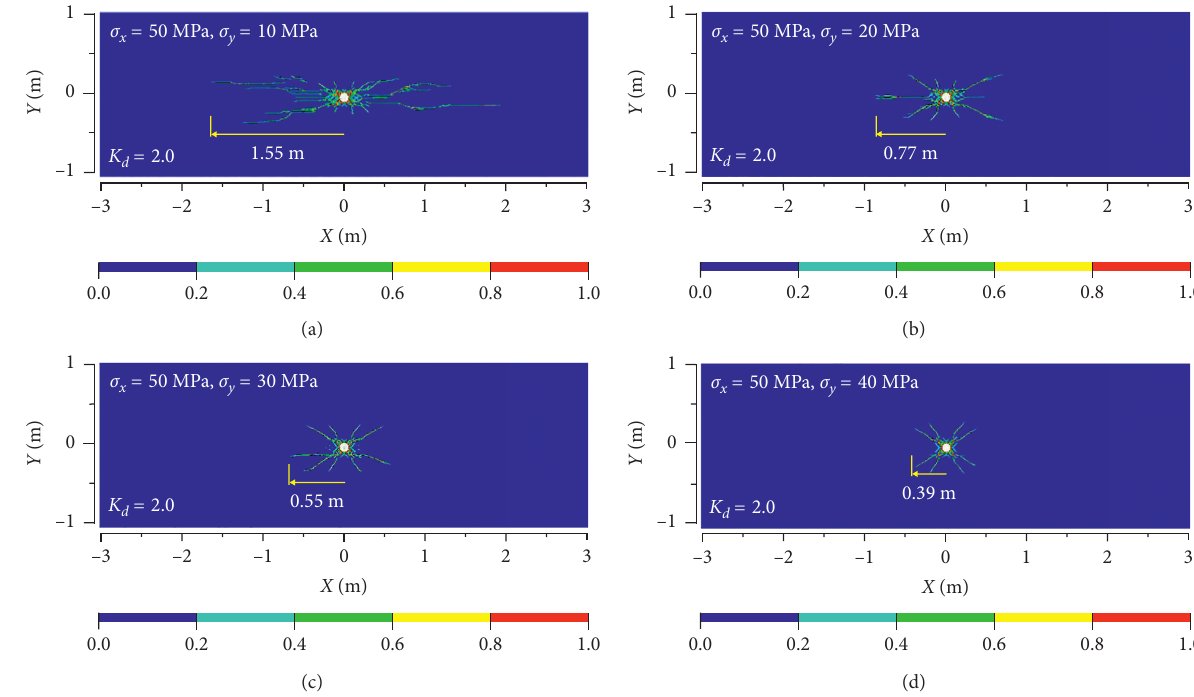
Figure 13: Crack patterns in different biaxial stress fields ( K σ x � 50MPa and σ y � 30MPa; (d) σ x � 50MPa and σ y � 40MPa.